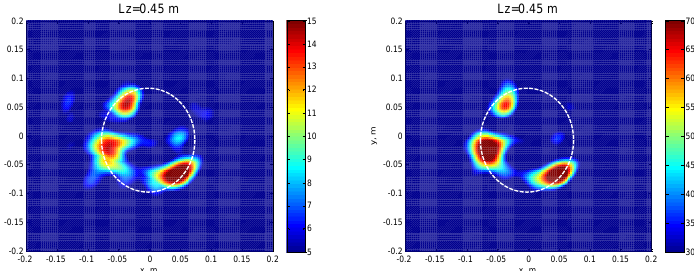
Figure 24. Results of multi-view holographic sensing of a metal disk, buried in the road bed.